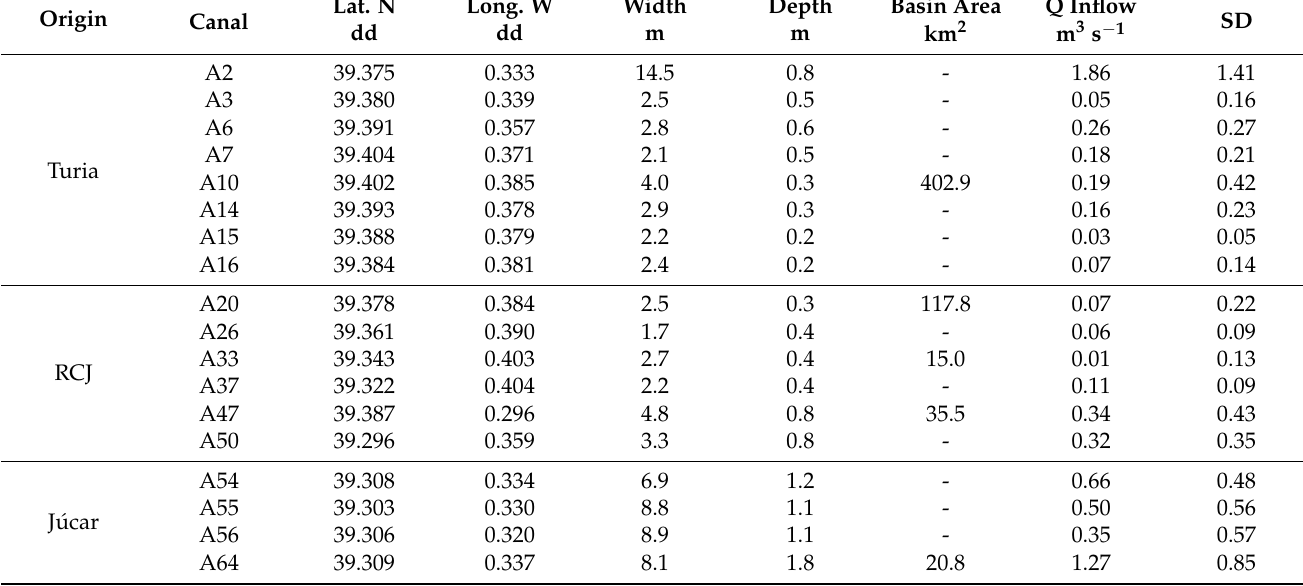
Figure 4. Average inflow for each of the most important ditches that inflow to the Albufera. Those identified with A2, A3, A34, A55 and A56 sometimes have reverse flow, and instead of water entering the lagoon, it is outflow. In blue color, waters coming from the Turia River; in green color, from the RCJ canal; in orange color, waters coming from the J ú car River. * indicates outlier values. Table 1. Ubication of each sampling point (Latitude and Longitude in decimal degree, dd); dimensions of canal (width and depth in m); average inflow and standard deviation (SD) for each canal, grouped by the origin of the water inflow to the lagoon from the Turia River, the RCJ and from the J ú car River. In bold font, the canals connected to natural basins and its catchment